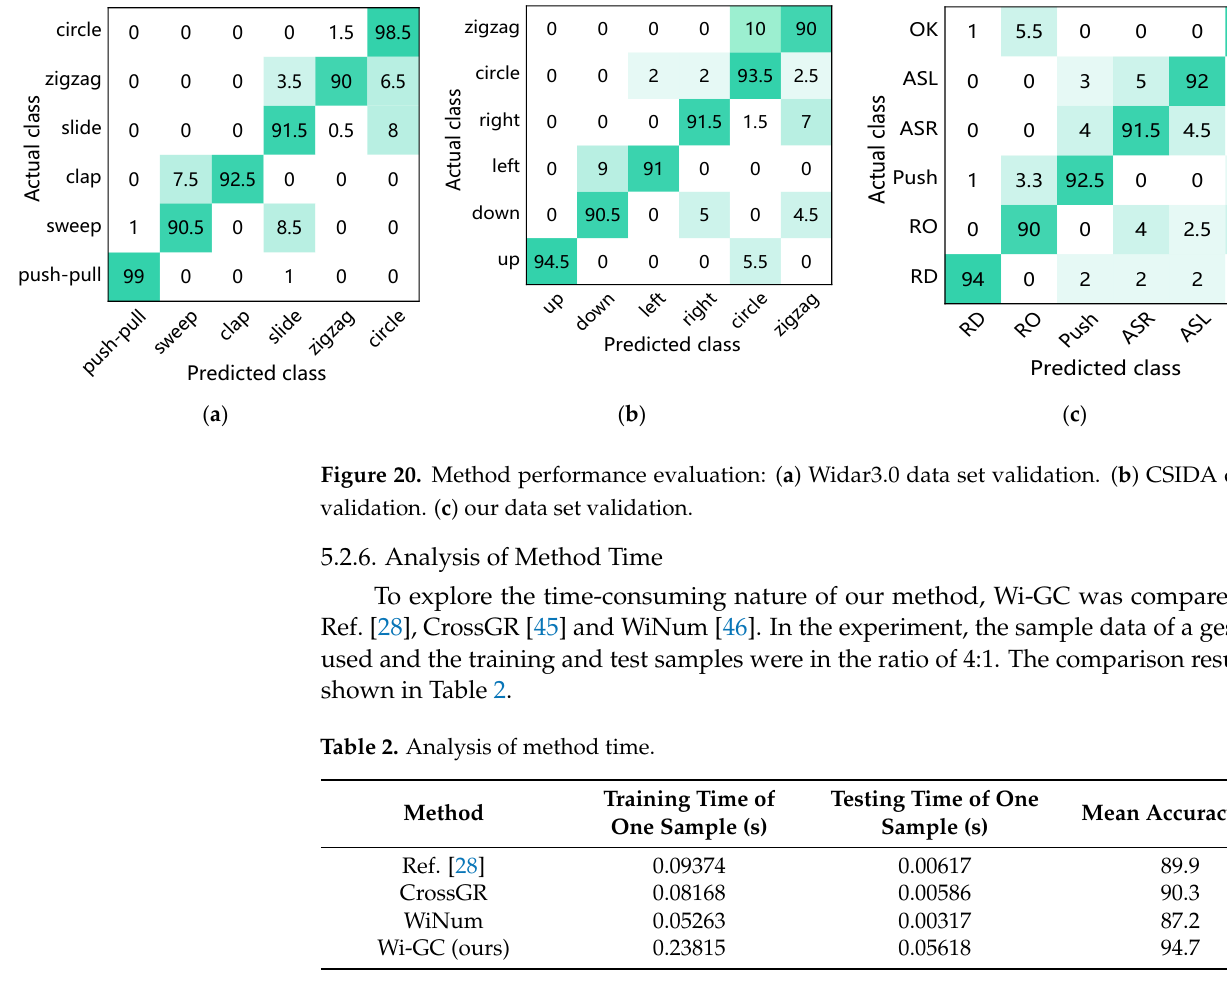
Table 2. Analysis of method time.